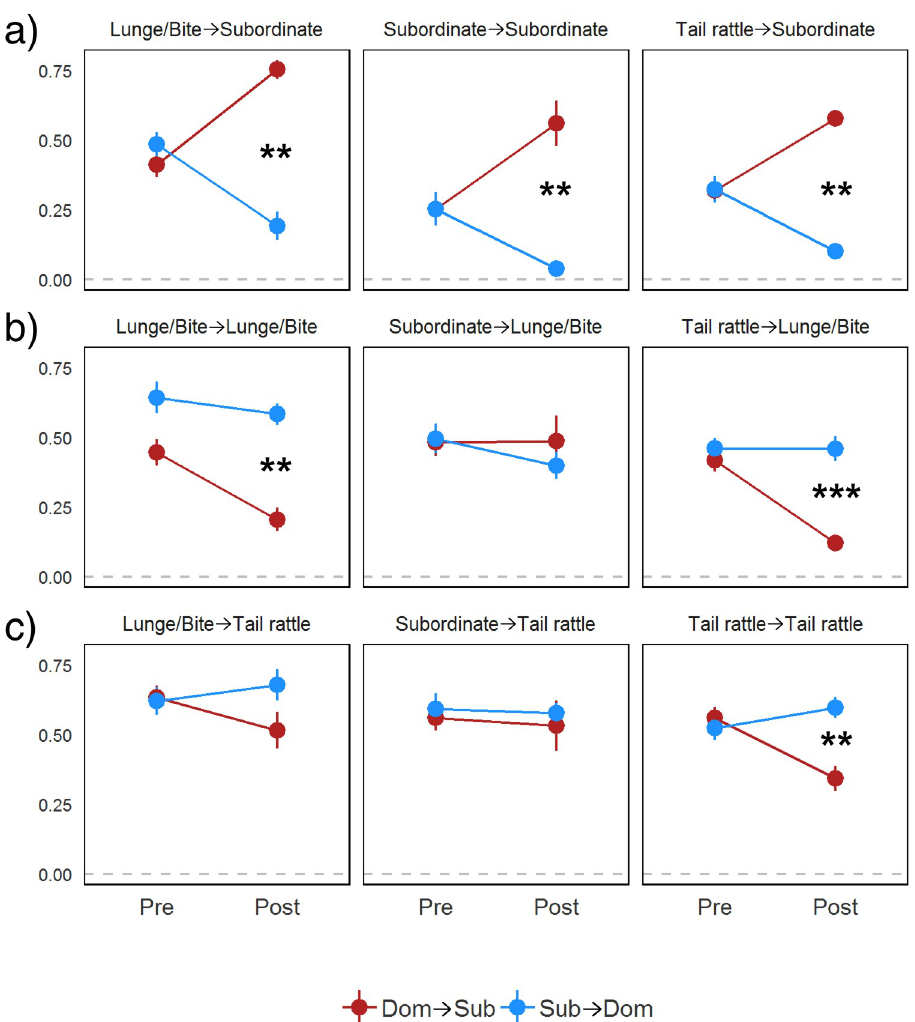
Fig 7. Forward STTC values with standard errors of nine selected contingencies in DOM ! SUB (red) and SUB ! DOM (blue) directions in pre- and post-resolution phases. The asterisks indicate significant differences between DOM ! SUB and SUB ! DOM directions. The differences in FSTTC values between the directions of each dyad were tested using paired Wilcoxon Signed Rank Tests. The asterisks indicate p-values from paired Wilcoxon Signed Rank Tests; � : p < 0.05, �� : p < 0.01, ��� : p < 0.001.